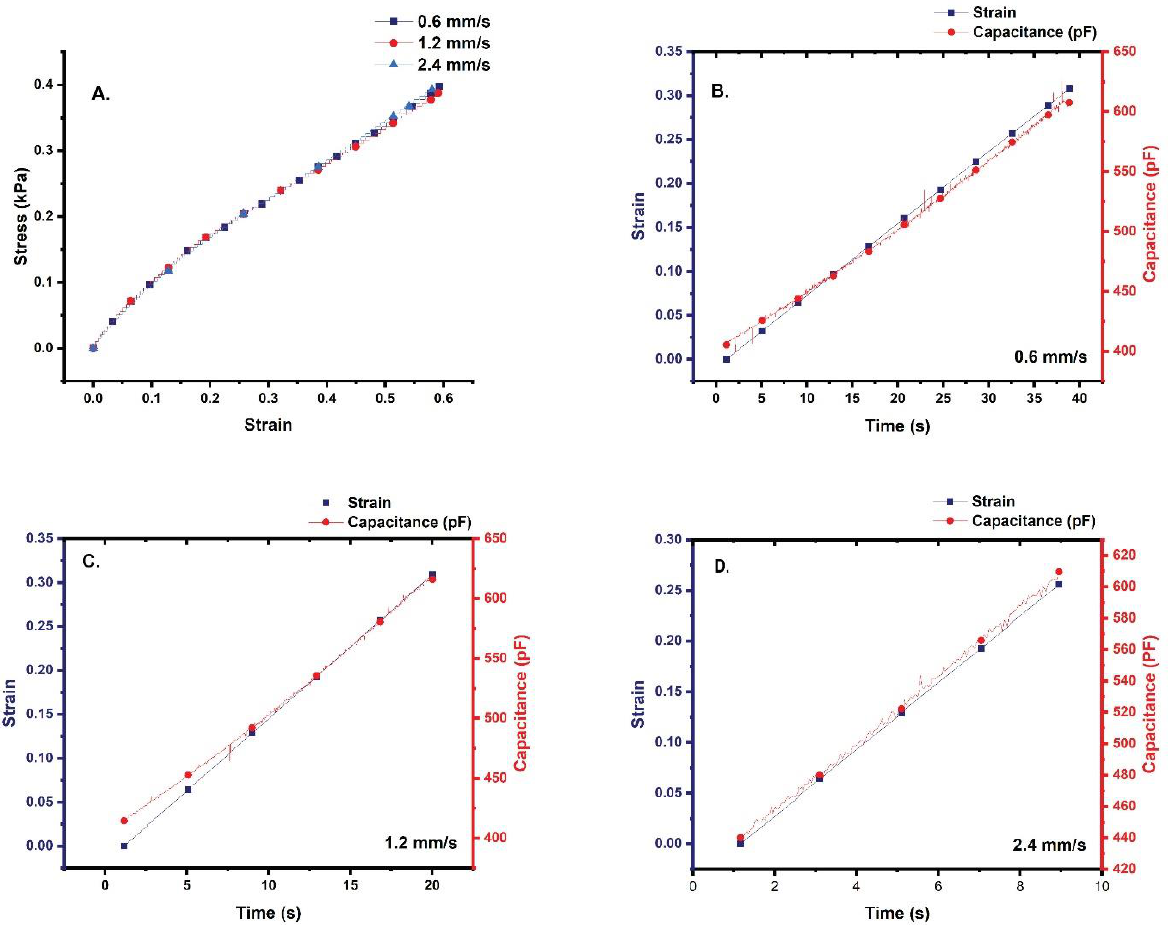
Figure 6. ( A ) Stress–strain curves produced from the quasi-static tensile testing of the stretch sensors. ( B ) Comparison of strain and capacitance at 0.6 mm/s. ( C ) Comparison of strain and capacitance at 1.2 mm/s. ( D ) Comparison of strain and capacitance at 2.4 mm/s. Note the differences in scale.